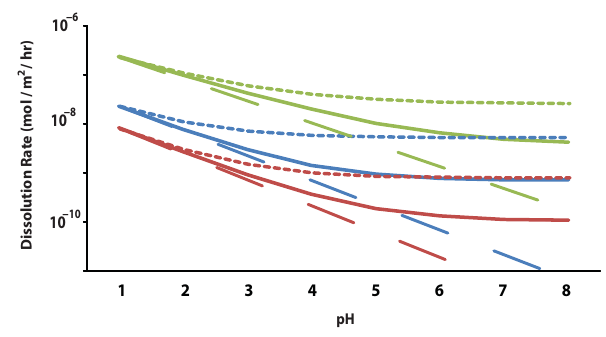
Fig. 1. Dissolution rates (molm − 2 h − 1 ) for hematite (blue), goethite (red), and illite (green) in atmospheric waters containing oxalate concentrations of 0µM (long-dashed lines), 1µM (solid lines) and 8µM (short-dashed lines) at